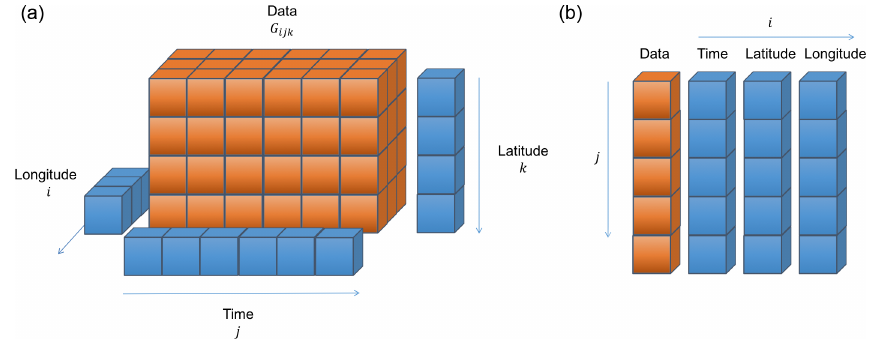
Figure 2. (a) An illustration of the design of the gridded data objects used internally by CIS – based heavily on the Iris cube. The n - dimensional data array G is accompanied by n one-dimensional coordinate arrays. Note that hybrid height and pressure coordinates can also be created and used as needed. (b) An illustration of the design of ungridded data objects used internally by CIS. All j points are assumed to be independent of each other. The data and associated coordinates are represented as a series of one-dimensional